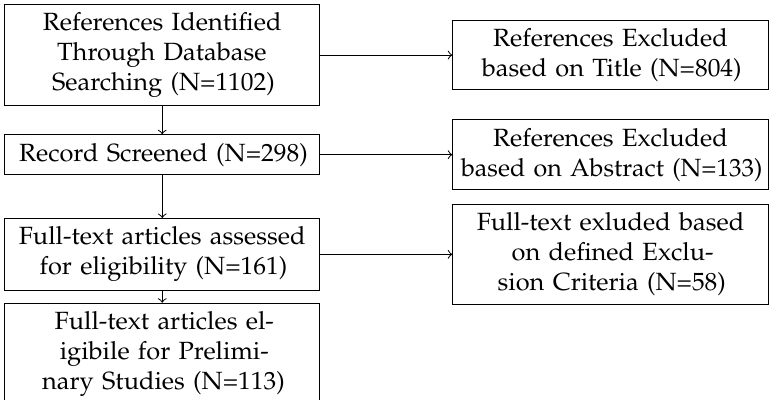
Figure 1. Procedure of research selection for the present schematic review based on PRISMA method- ology [45].